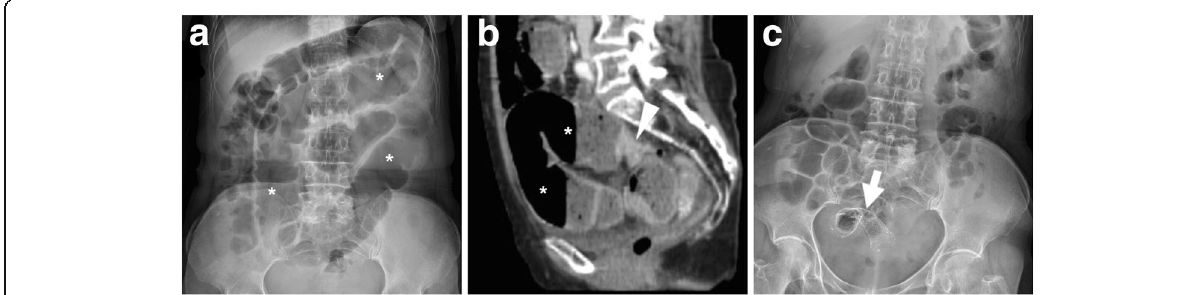
Fig. 7 Effective relief of LBO during bridge-to-surgery stenting of CRC. Initial supine ( a ) radiograph shows marked gaseous dilatation of the large bowel (*) consistent with LBO. Sagittal post-contrast CT image ( b ) confirm air-fluid colonic dilatation (*) above a short stricturing sigmoid tumour (arrowheads). Forty-eight hours after endoscopic positioning of a SEMS (thick arrow), a plain radiograph ( c ) shows near-complete resolution of